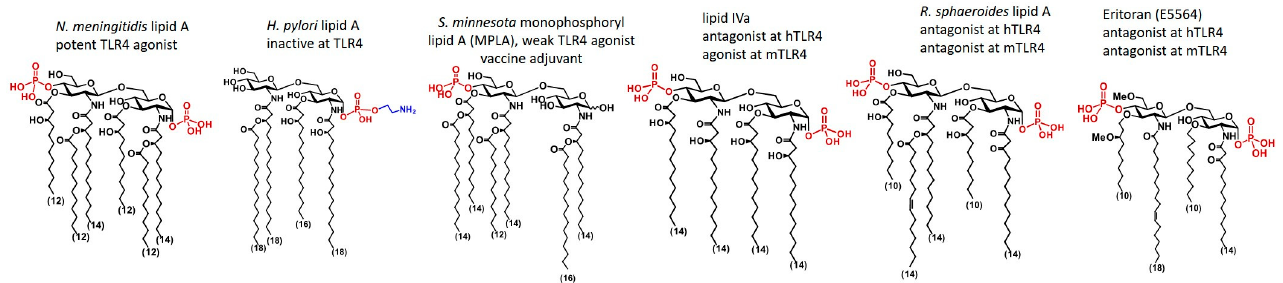
Figure 3. Chemical structure of several lipid A variants.